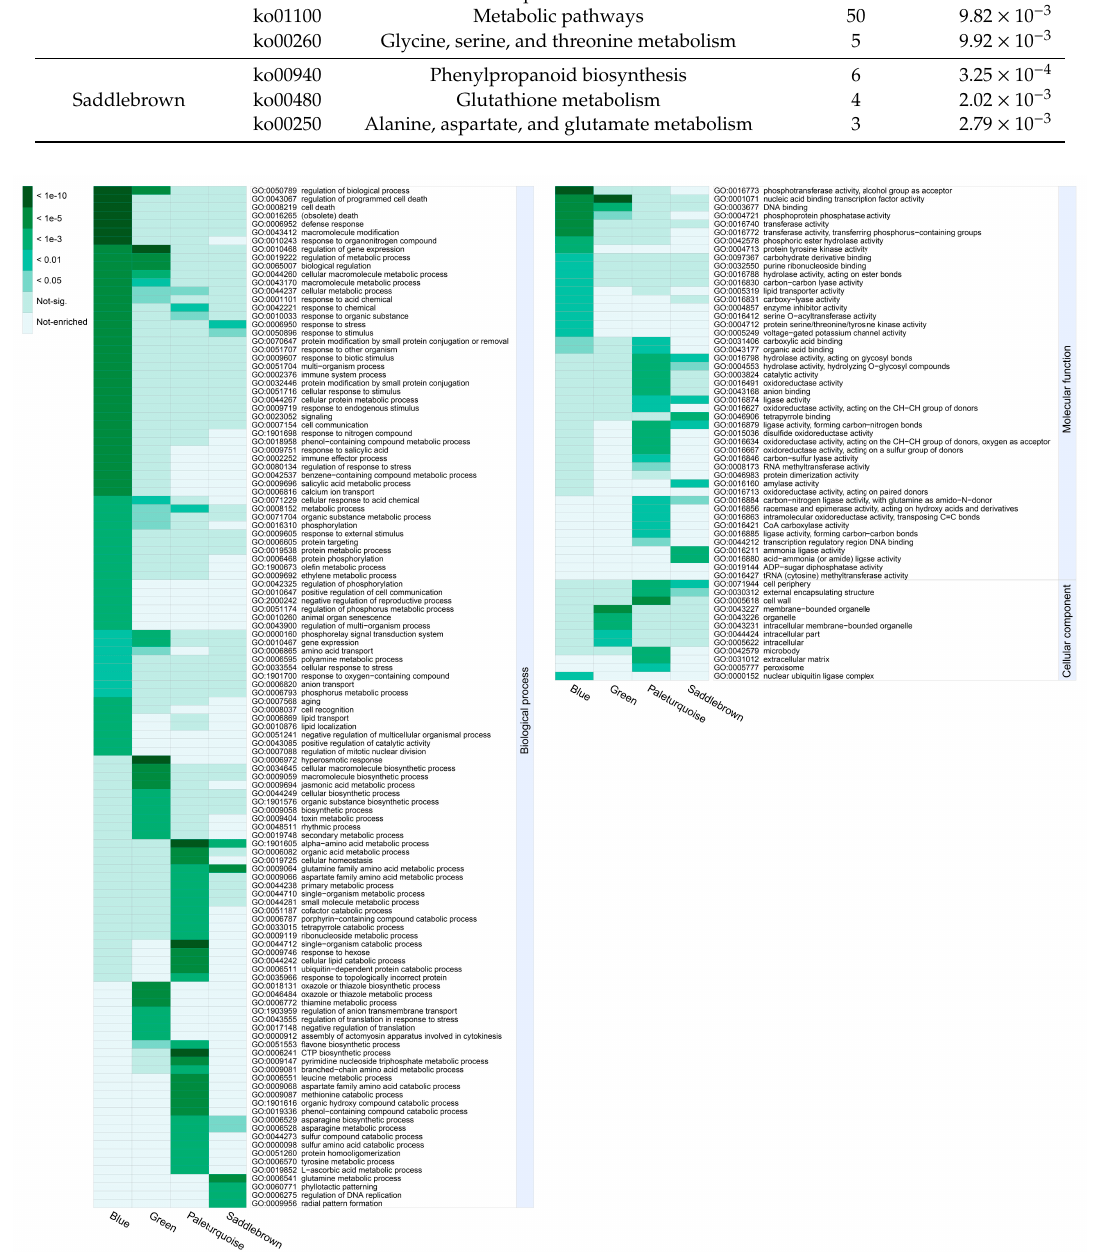
Figure 6. GO enrichment analysis of four significant modules. All significant GO-terms presented in the heatmap have been de-redundant with the REVIGO online platform. Each column represents a significant module, and each row represents a GO-term that is significantly ( p -value < 0.01) enriched in at least one module. The color scale on the left represents specific intervals of significance level (corrected p